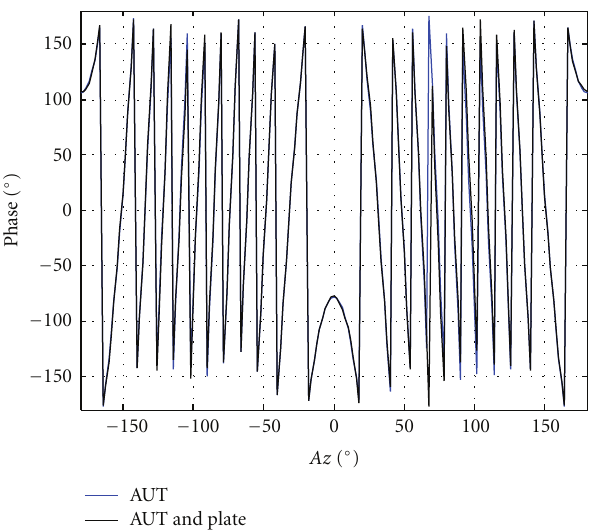
Figure 2: Far-field amplitude pattern of OEWG with and without plate. AUT o ff set = 10cm.